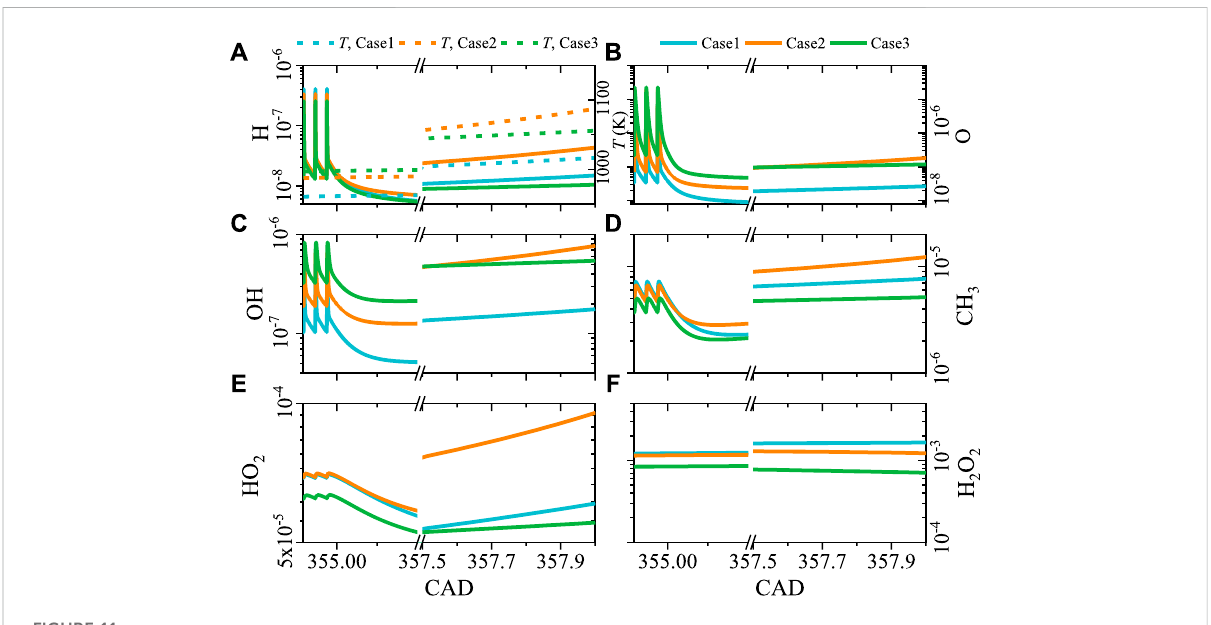
FIGURE 11 Evolution of (A) H, (B) O, (C) OH, (D) CH 3 , (E) HO 2 , and (F) H 2 O 2 mole fractions after